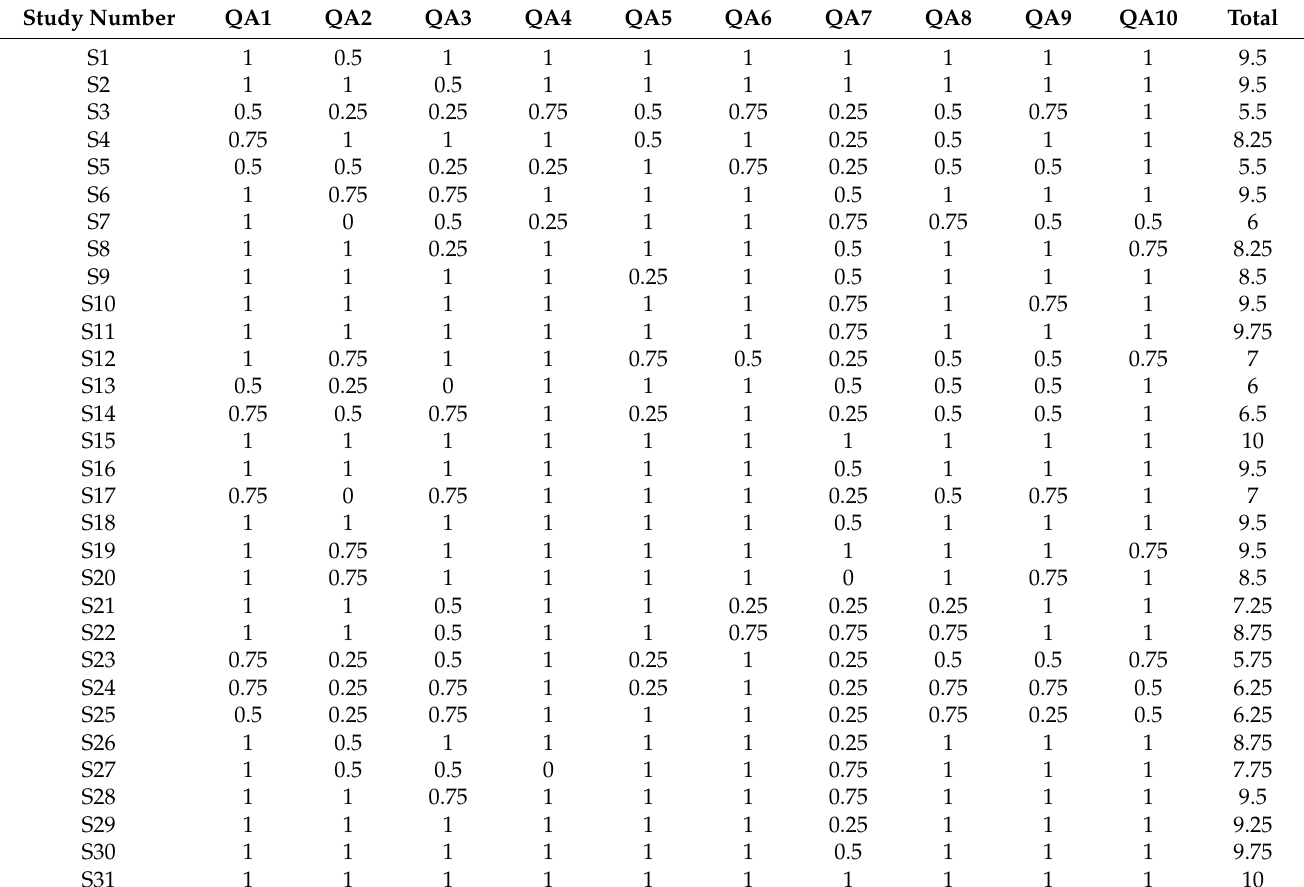
Table 5. Quality assessment of the selected